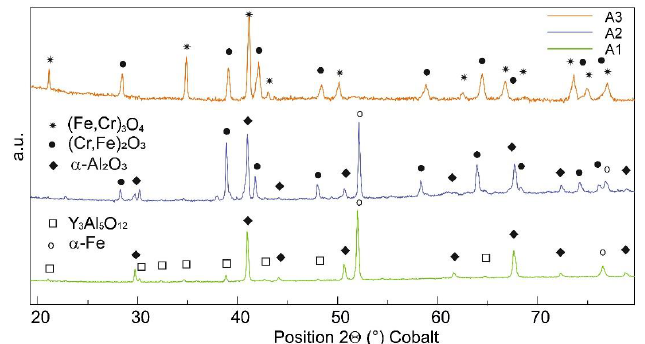
Figure 6. X-ray diffraction (XRD) spectra and phase analysis of oxide layers on surfaces of grades A1, A2 and A3 after the exposure for 64 h/1200 °C.